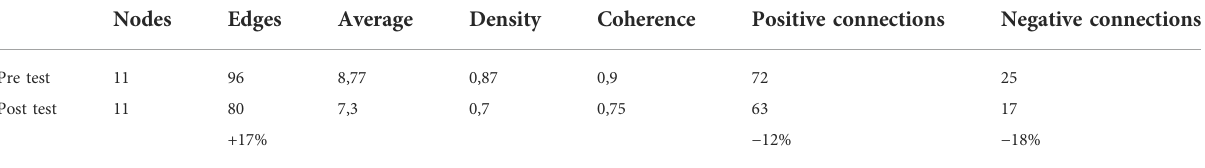
TABLE 4 Sociometric index calculated for the control group (group organization). Nodes Edges Average Density Coherence Positive connections Negative